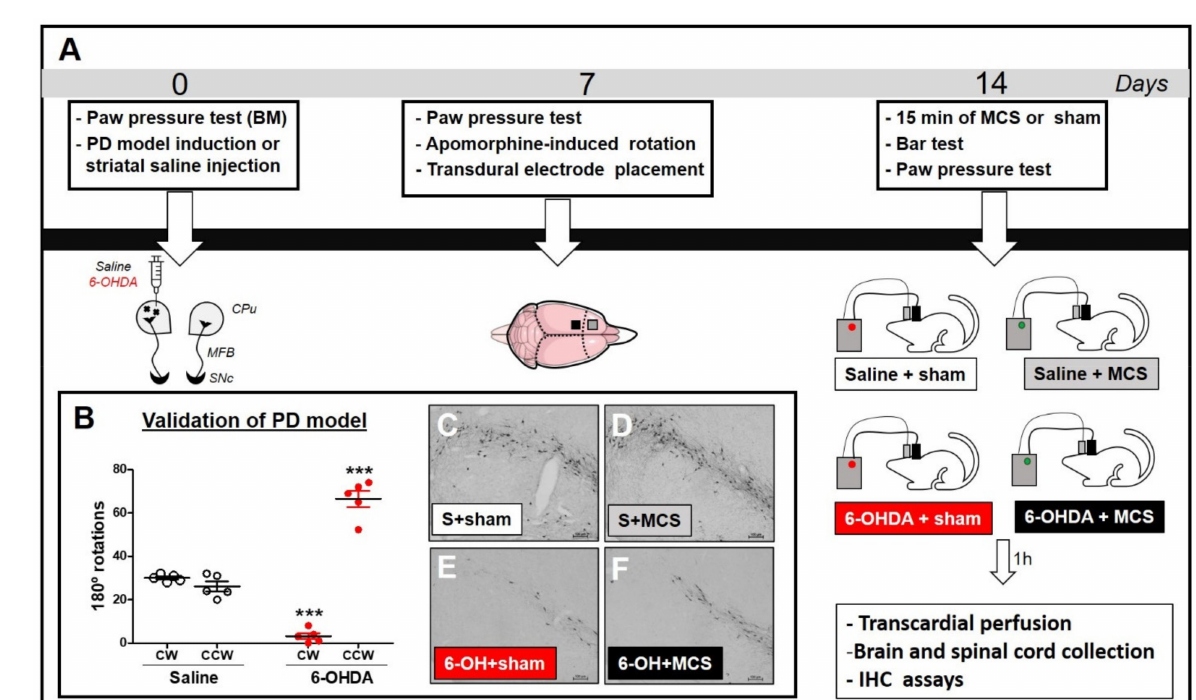
Figure 1. Experimental design ( A ). Animals were evaluated in the paw pressure test, anesthetized, and injected with 6-OHDA (to induce the experimental PD model, ePD) or saline (control group) in the left striatum. Animals were re- evaluated in the paw pressure test and apomorphine-induced rotation test 7 days after striatal injections to validate the ePD model. Next, animals underwent implantation of the transdural electrode in the motor cortex. Fourteen days after the PD model induction, animals were submitted to motor cortex stimulation (MCS) or sham for 15 min and re-evaluated in the paw pressure test. One hour after the last nociceptive evaluation, the brains and spinal cords were collected for immunohistochemistry (IHC) assays. Control animals, whether submitted to MCS or not, were also evaluated. The immunoreactivity of tyrosine hydroxylase (a marker of dopaminergic neurons) in the substantia nigra (SN), serotonin in the nucleus raphe magnus (NRM), and c-Fos, GFAP, and Iba-1 in the dorsal horn of the spinal cord (DHSC) were evaluated by IHC. Evaluation of apomorphine-induced rotation ( B ) to confirm dopaminergic deficit. Values represent the mean + SEM. *** p < 0.001 when compared to the control group (saline). Photomicrographs of immunoreactivity for TH ( C – F ) of rat saline + sham (S + sham, ( C )), rat saline + MCS (S + MCS, ( D )), rat 6-OHDA + sham (6-OH + sham, ( E )), and rat 6-OHDA +